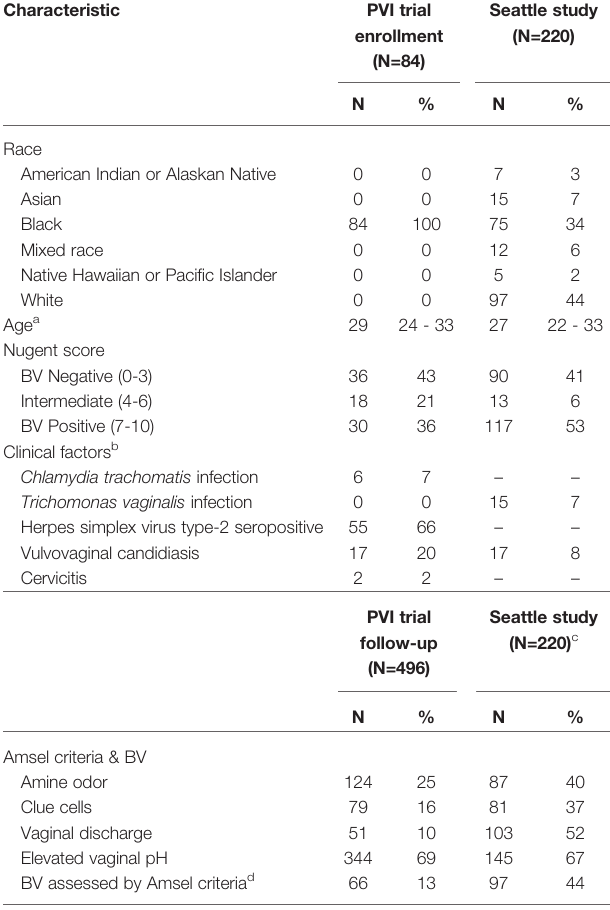
TABLE 1 | Baseline characteristics and Amsel criteria prevalence in the PVI trial and Seattle study populations.